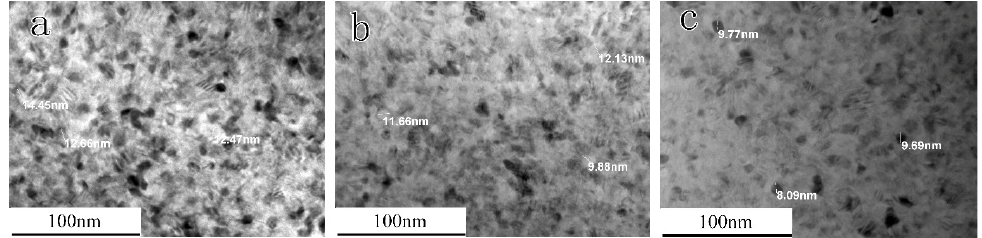
Figure 2. TEM of coatings deposited at different current. ( a ) DC 400 °C heat treated; ( b ) SP 400 °C heat treated; ( c ) DP 400 °C heat treated.